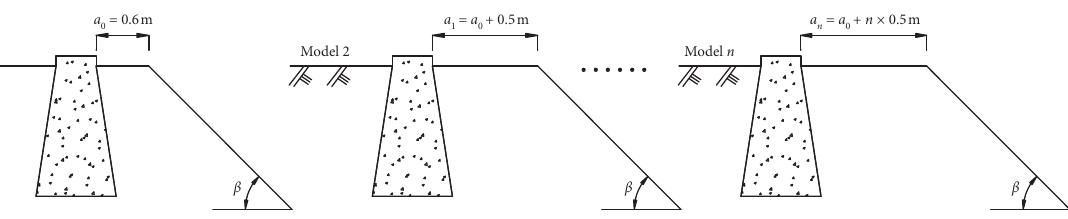
Figure 6: Flow chart of the numerical analysis scheme.